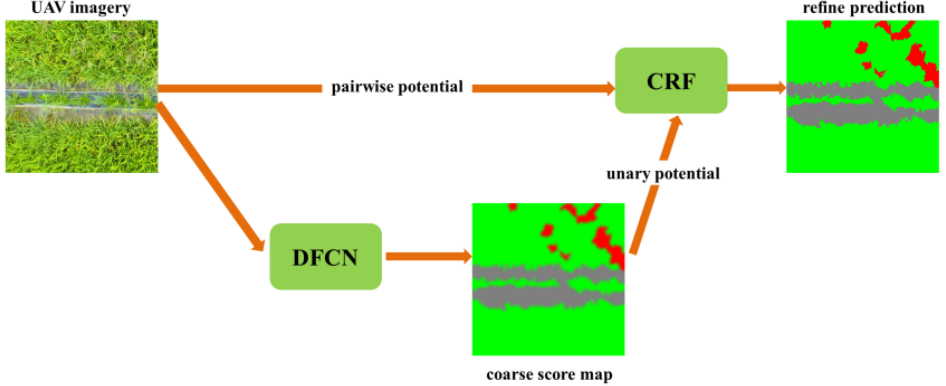
Figure 8. Illustration of the fully connected CRF.